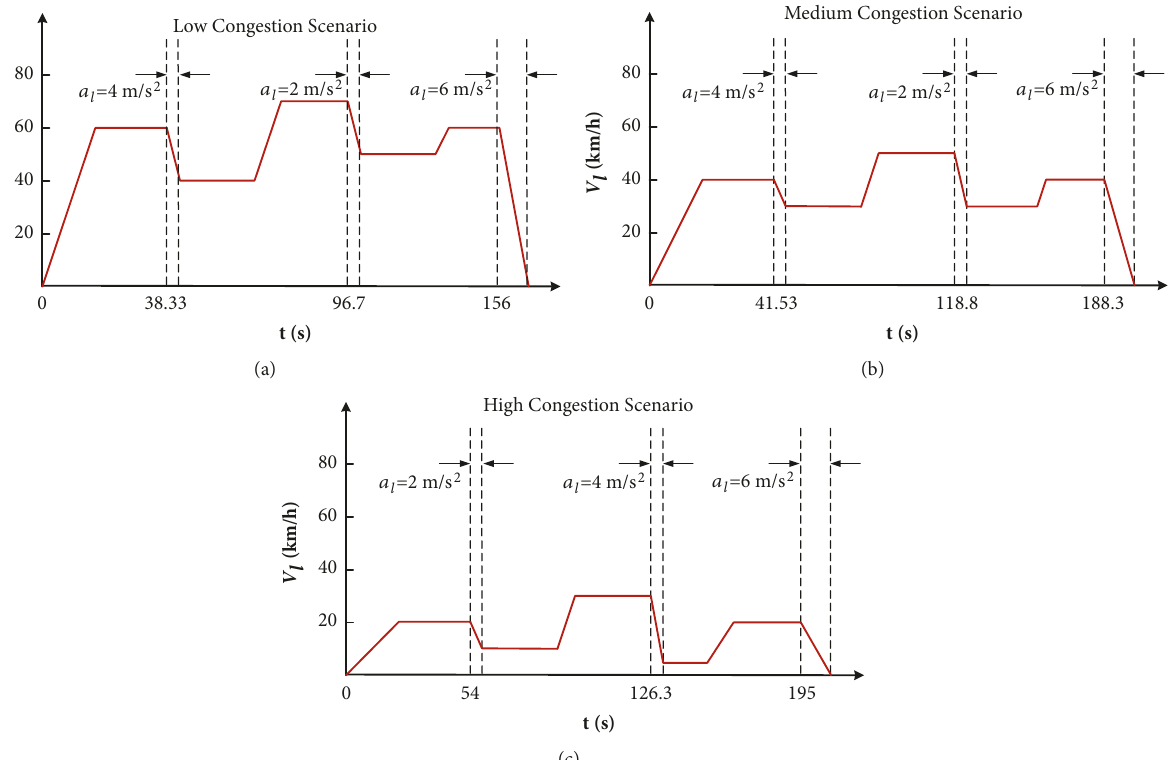
Figure 4: Speed and decelerationrateof the lead vehiclein low congestion scenario (a),medium congestion scenario (b), and highcongestion scenario (c),